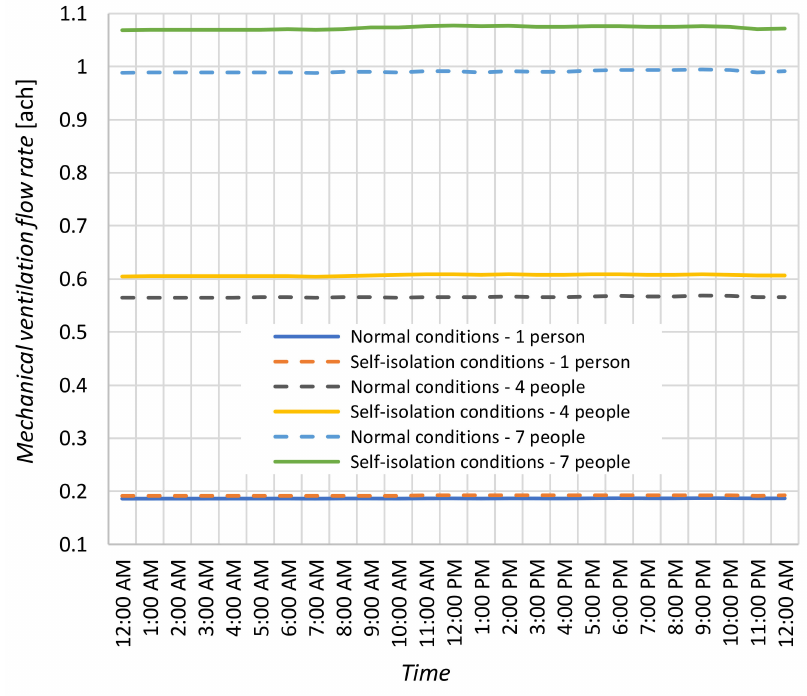
Figure 18. Change of the ventilation airflow